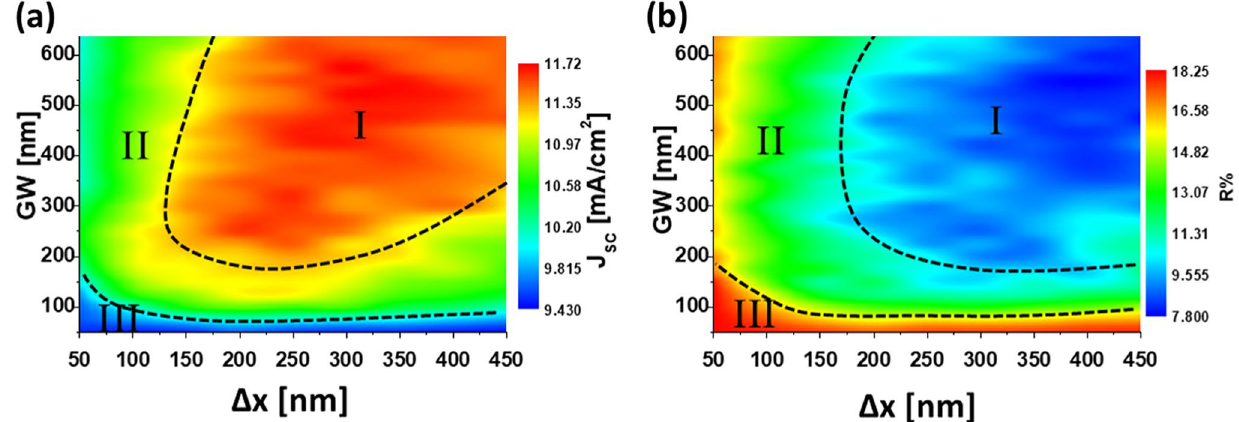
Figure 3. Maps of the short circuit current, J SC ( a ), and the reflectance, R ( b ), within the spectral range (cid:31) ∈ ( 300, 800 ) nm, in terms of (cid:31) x and GW geometrical parameters. The material of the metasurface elements is GaP.